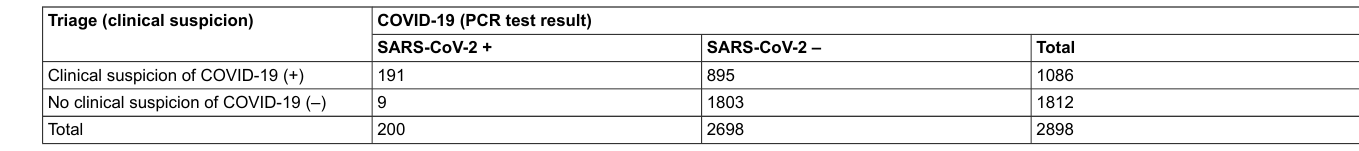
Table 1: Overview of clinical suspicion and plymerase chain reaction (PCR) test